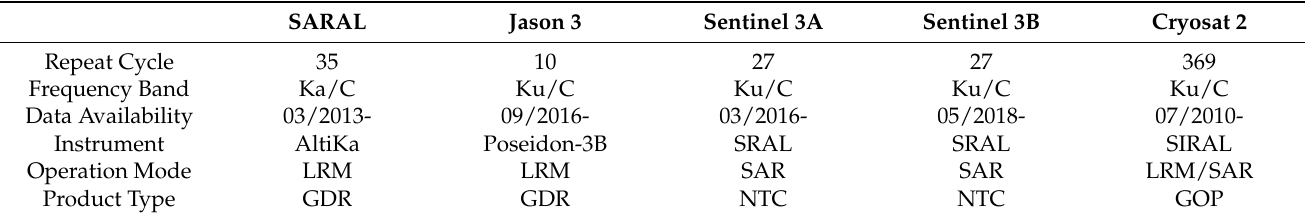
Table 1. Satellite altimeters used in this study and their